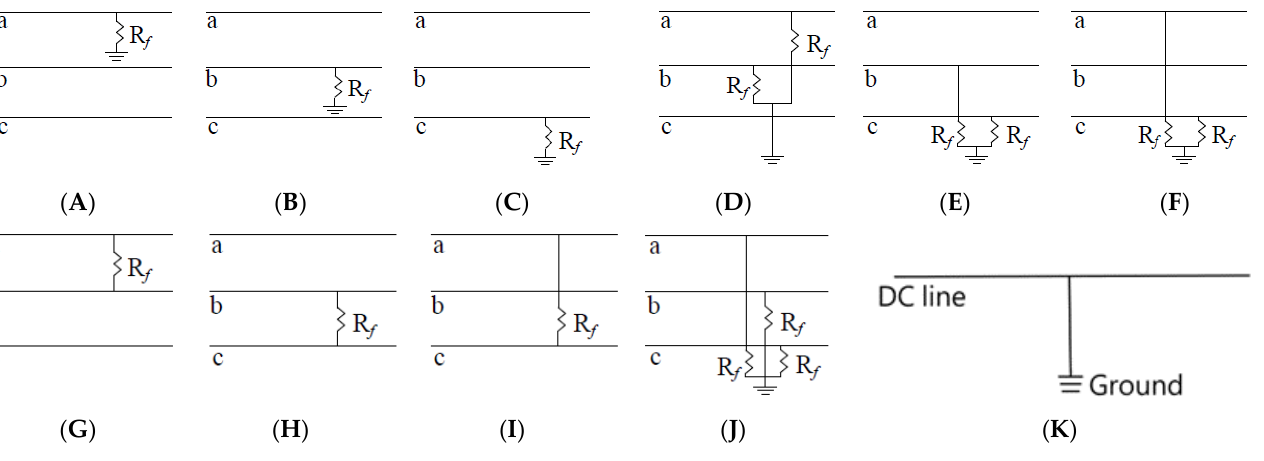
Figure 1. HVDC system fault classes ( A ) a-g, ( B ) b-g, ( C ) c-g, ( D ) ab-g, ( E ) bc-g, ( F ) ac-g, ( G )